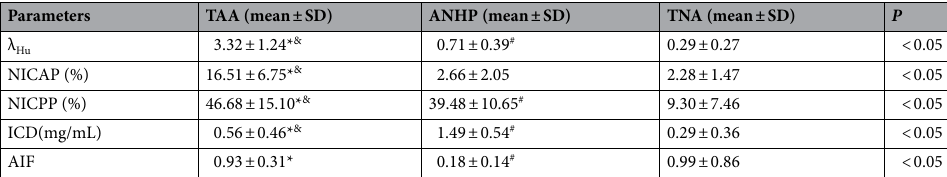
Table 4. Comparison of various parameters in different liver tissues after TACE. λ Hu , slope of the spectral Hounsfield unit curve; NICAP, normalized iodine concentration at arterial phase; NICPP, normalized iodine concentration at portal venous phase; ICD, iodine concentration difference; AIF, arterial iodine fraction; TAA, tumor active area; ANHP, adjacent normal hepatic parenchyma; TNA, tumor necrotic area. *Indicates a significant difference between TAA and ANHP ( P < 0.05). # Indicates a significant difference between TNA and ANHP ( P < 0.05). & Indicates a significant difference between TAA and TNA ( P < 0.05).